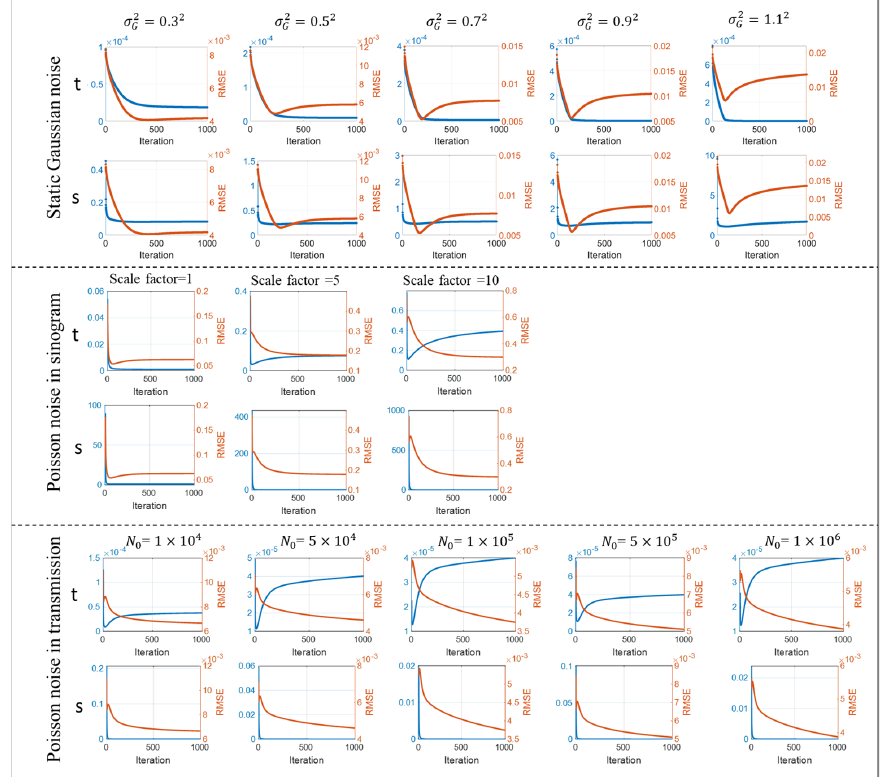
Figure 4. Stopping criterion under three different noise types. The change of two unobservable parameters ( s , t ) and change of image quality (RMSE) along with iteration are plotted.